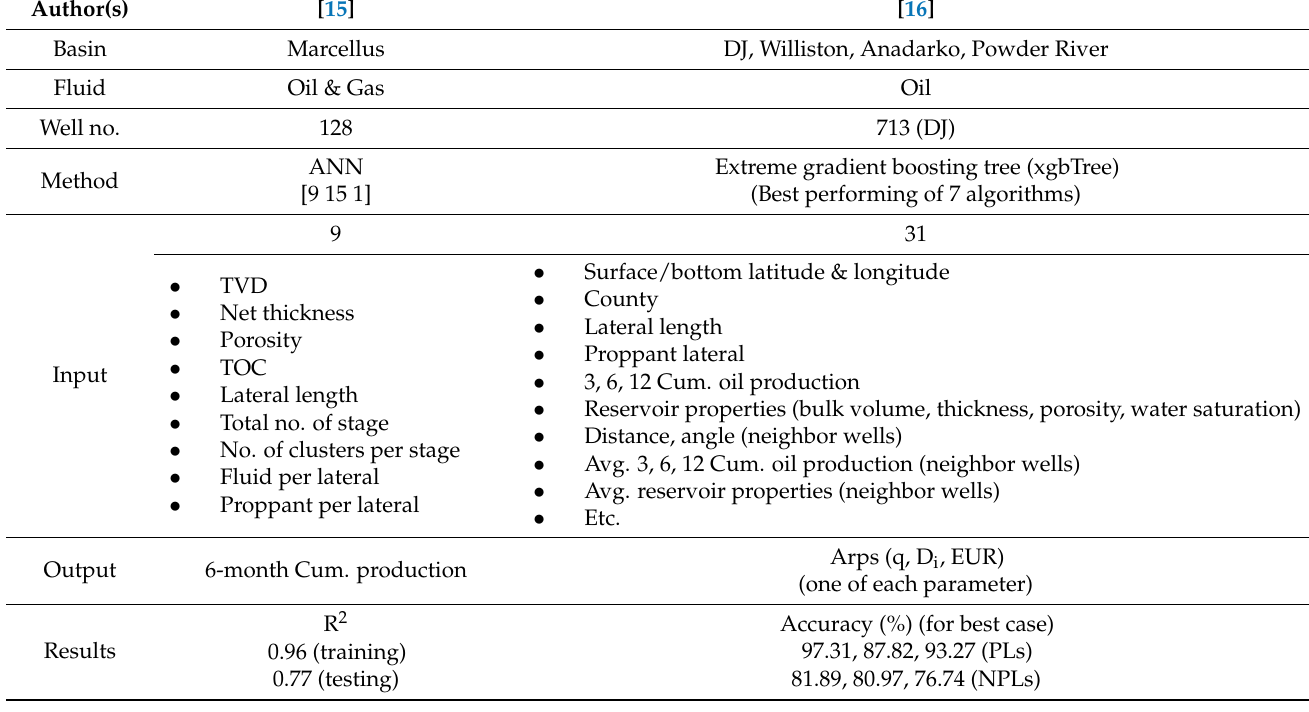
Table 2. Research on productivity prediction of new wells in shale